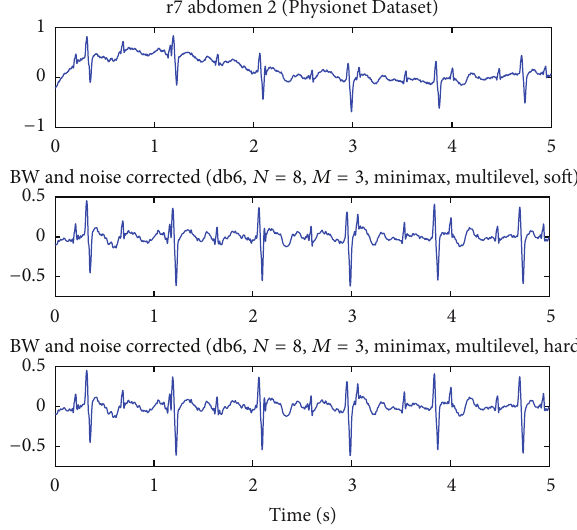
Figure 11: r7 abdomen 2 Abdominal and Direct Fetal Electrocar- diogram Database (Physionet Dataset) signal and BW and noise corrected signals using the two types of thresholding rules.